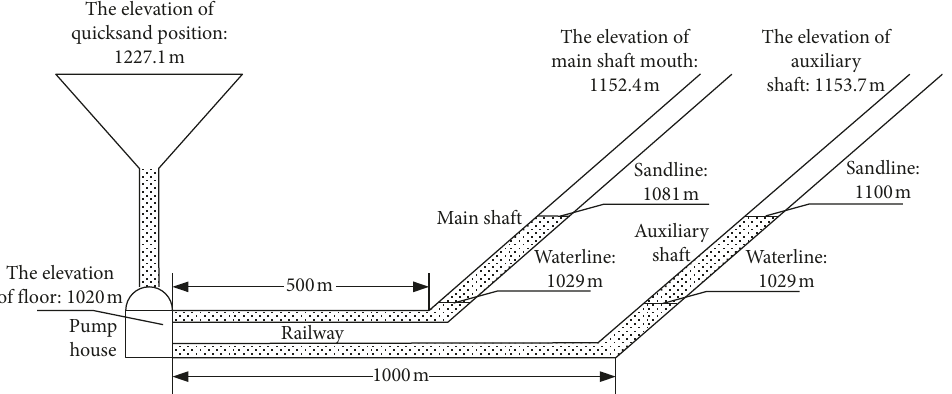
Figure 3: The profile after water inrush and quicksand disaster.